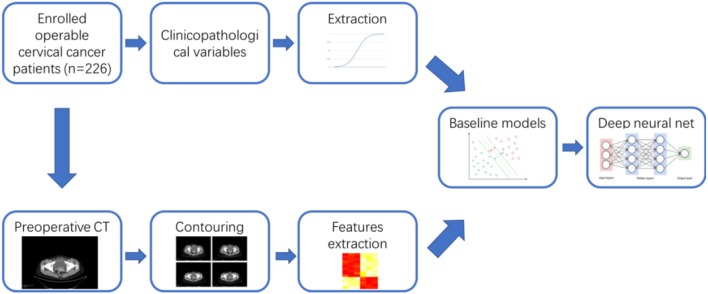
Global analysis pipeline.